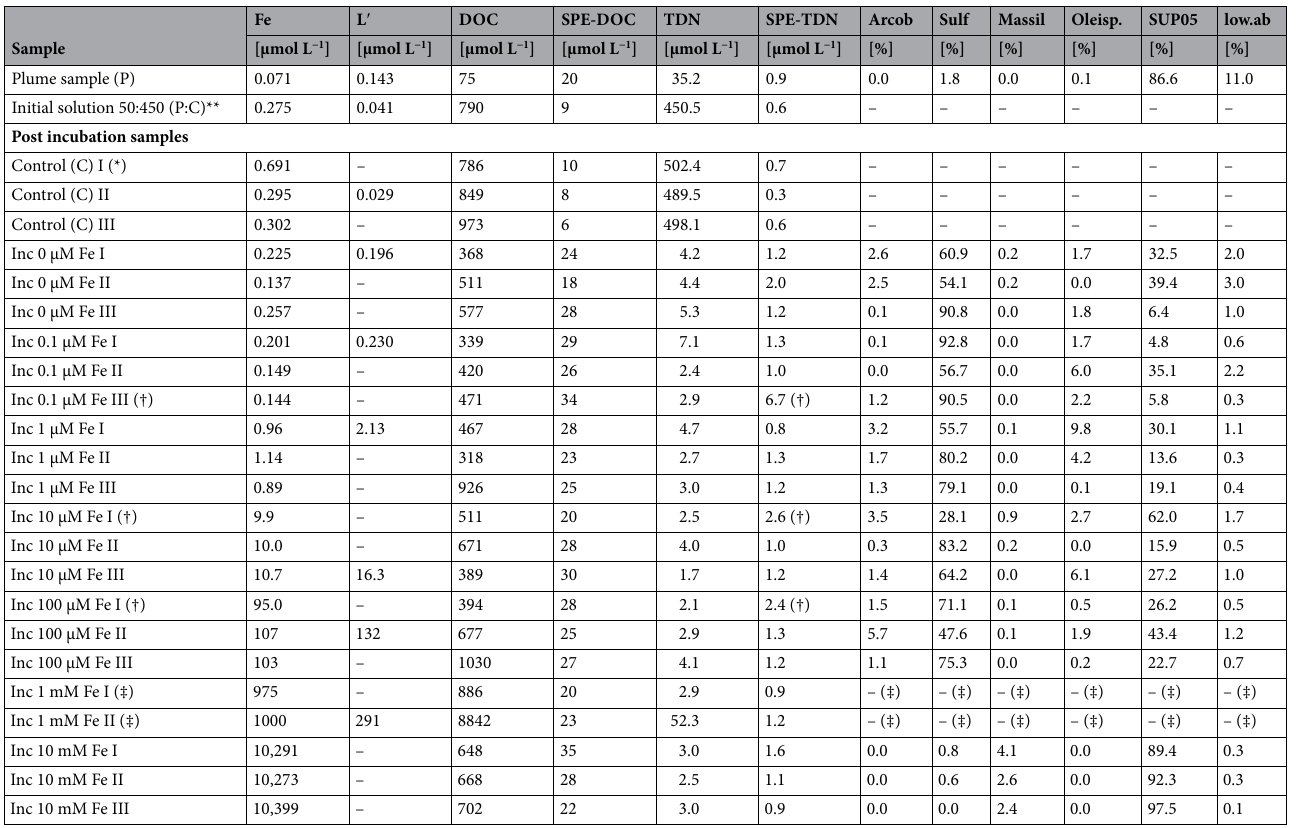
Table 1. Dissolved iron (dFe), iron-binding ligand excess (L ′ ), dissolved organic carbon (DOC,